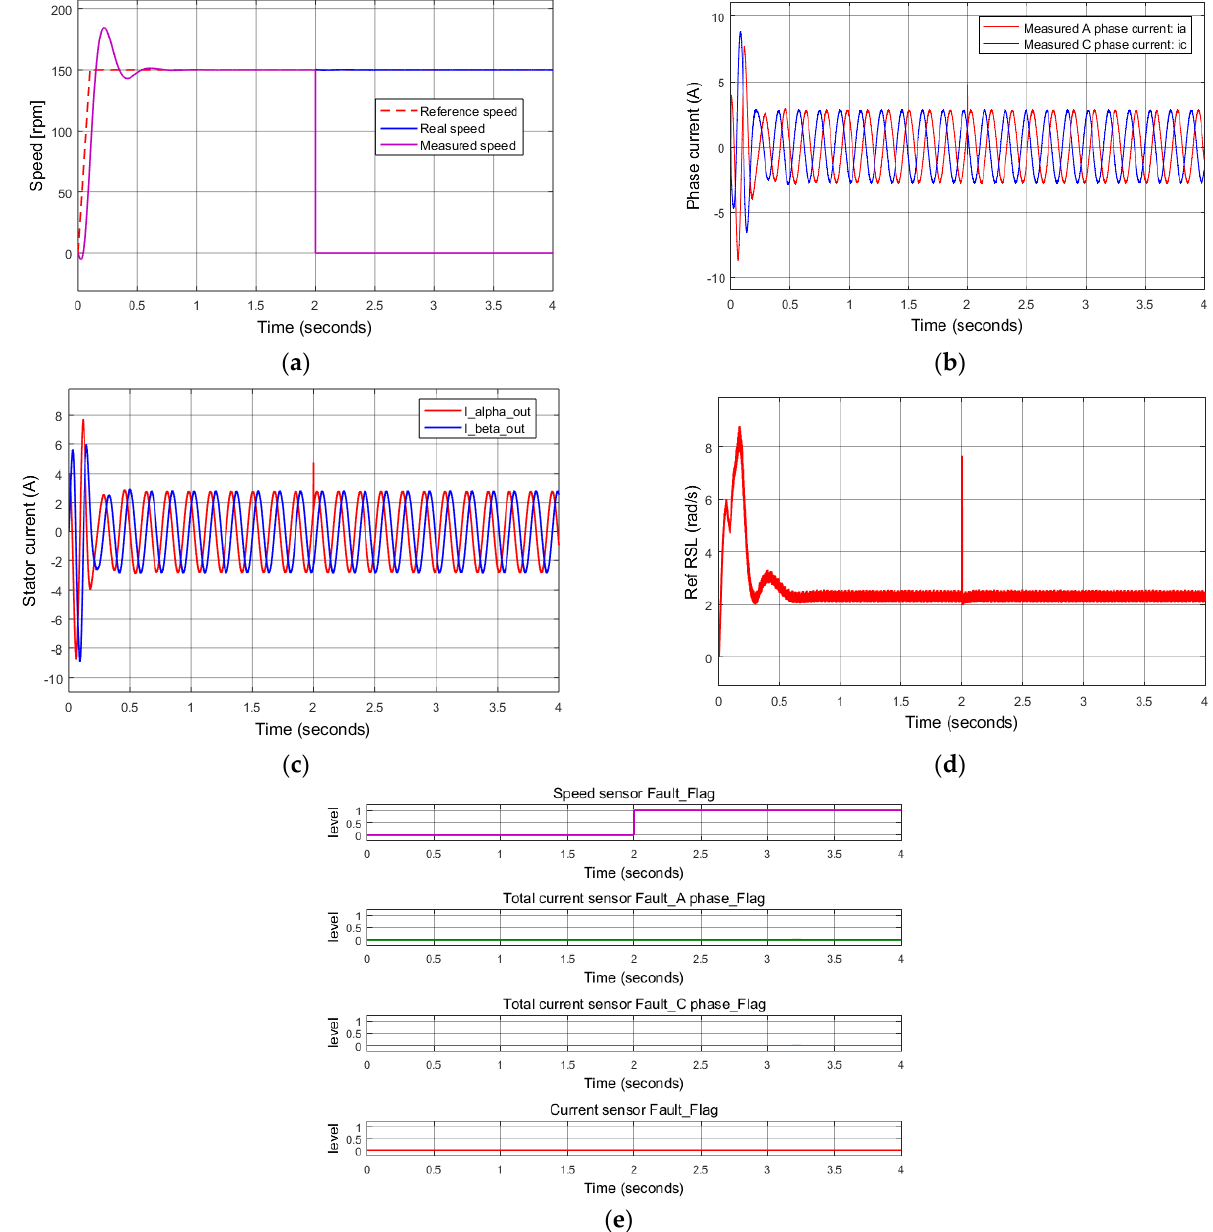
Figure 8. Simulation results: total rotor speed sensor failure at 2 s. ( a ) Reference, real, measured speeds; ( b ) measured current; ( c ) stator current vector components for FOC controllers (FTC outputs); ( d ) reference rotor slip; ( e ) sensor fault indications.